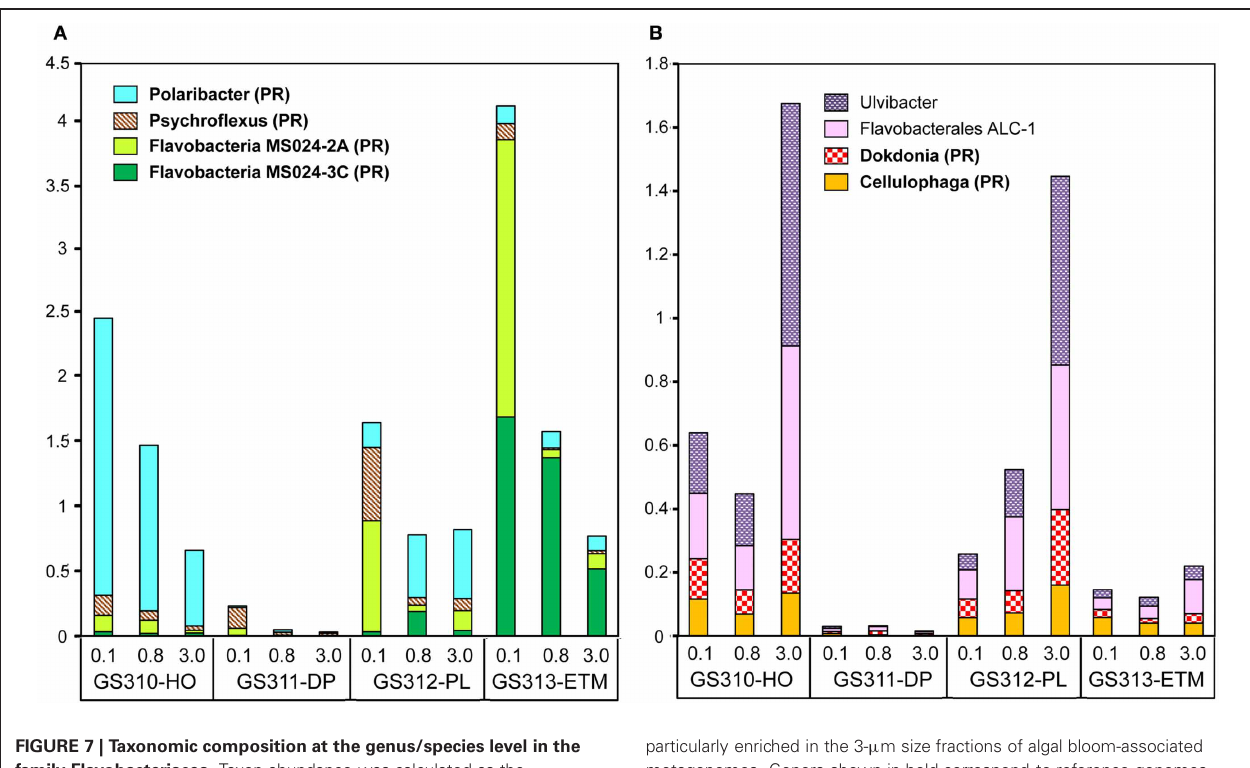
FIGURE 7 | Taxonomic composition at the genus/species level in the family Flavobacteriacea. Taxon abundance was calculated as the percentage of all hits with > 90% identity (over > 70% of the alignment length) to the total annotated prokaryotic peptides in the corresponding metagenome. (A) Taxa particularly enriched in 0.1- μ m size fractions. (B) Taxa